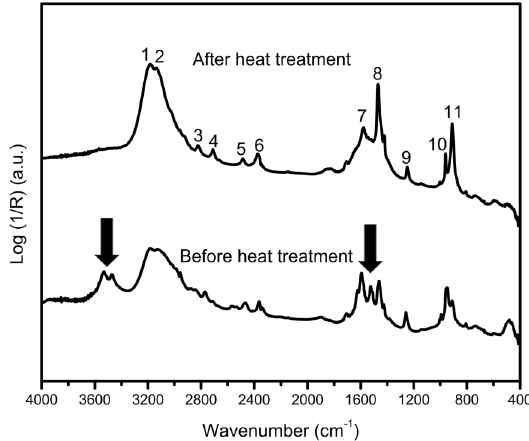
Figure 4. FTIR spectra of the perovskite 24-h films fabricated via spray deposition at 100°C and annealed for 30 s before and after heat Table 2. FTIR peak assignments of the CH thin films. Wavenumber Peak (cm -1 )